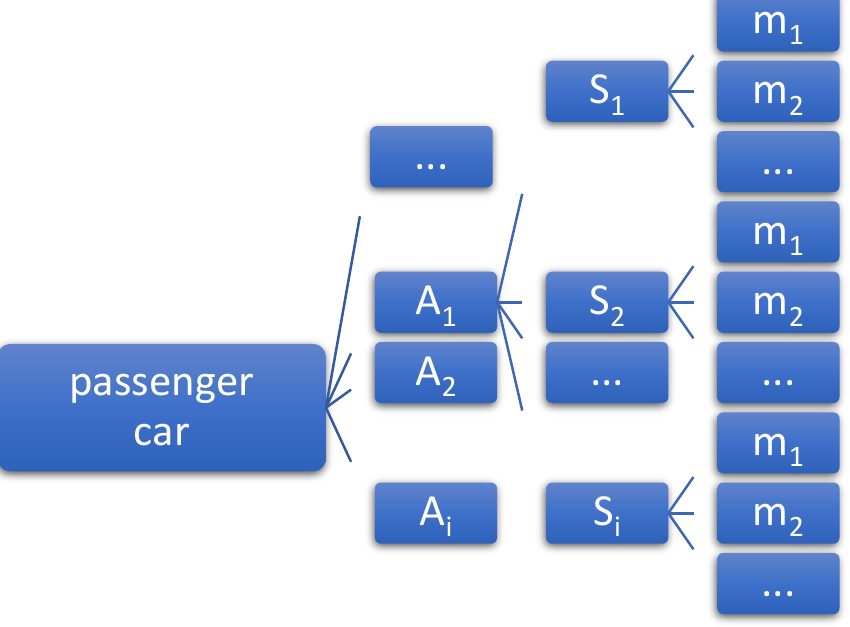
Figure 1. Analytical model of passenger car decomposition.